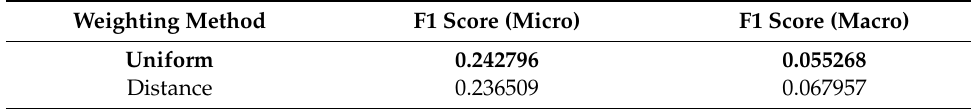
Table A3. KNN tuning: F1 score (micro and macro averaged) using uniform weighting compared to distance weighting. Although the F1 macro average score is higher for distance weighing, micro averaging is less susceptible to fluctuations from class imbalance, therefore this was chosen as the deciding factor. Tests performed using the constant processing pipeline. Selected weighting method shown in bold.